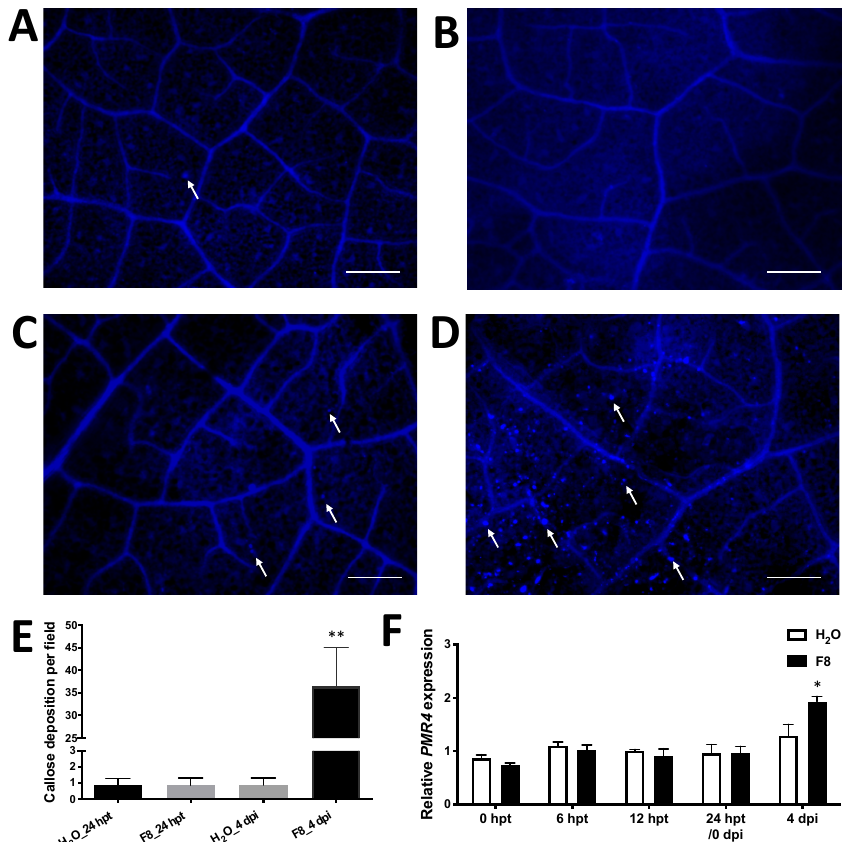
Figure 5. Staining of callose deposition in F8-culture filtrate or H 2 O pretreated Yu-Nu tomato before or after TYLCTHV inoculation. Tomato plants were pretreated with H 2 O ( A , C ) or F8-culture filtrate ( B , D ). The pretreated plants were inoculated with TYLCTHV using whitefly vector at 24 hpt. The callose deposition was stained with 0.02% aniline blue. Callose depositions were analyzed at 24 hpt without TYLCTHV infection ( A , B ) or with TYLCTHV infection at 4 dpi ( C , D ) using a Zeiss Imager Z1 fluorescence microscope. Scale bar = 200 μ m. White arrow indicates callose depositions. ( E ) The average numbers of callose deposition per field. Two pictures were taken per leaf (TYLCTHV-inoculated) collected from each plant ( n = 7 plants) from H 2 O or F8-culture filtrate treatment for analysis. Data shows mean number of callose deposition per field ± SEM. Student’s t -test was used to analyze the data from the F8-culture filtrate pretreated group and the H 2 O-pretreated control group. ** p < 0.01. ( F ) The relative expression of callose synthase gene PMR4 was detected by qRT-PCR at 0, 12 and 24 hpt without TYLCTHV infection or with TYLCTHV infection at 4 dpi. Data are mean ± SEM from 3 plants. β -actin was used as an input control. Student’s t -test was used for comparative analysis of the data in the H 2 O and F8-culture filtrate pretreated groups. * p <